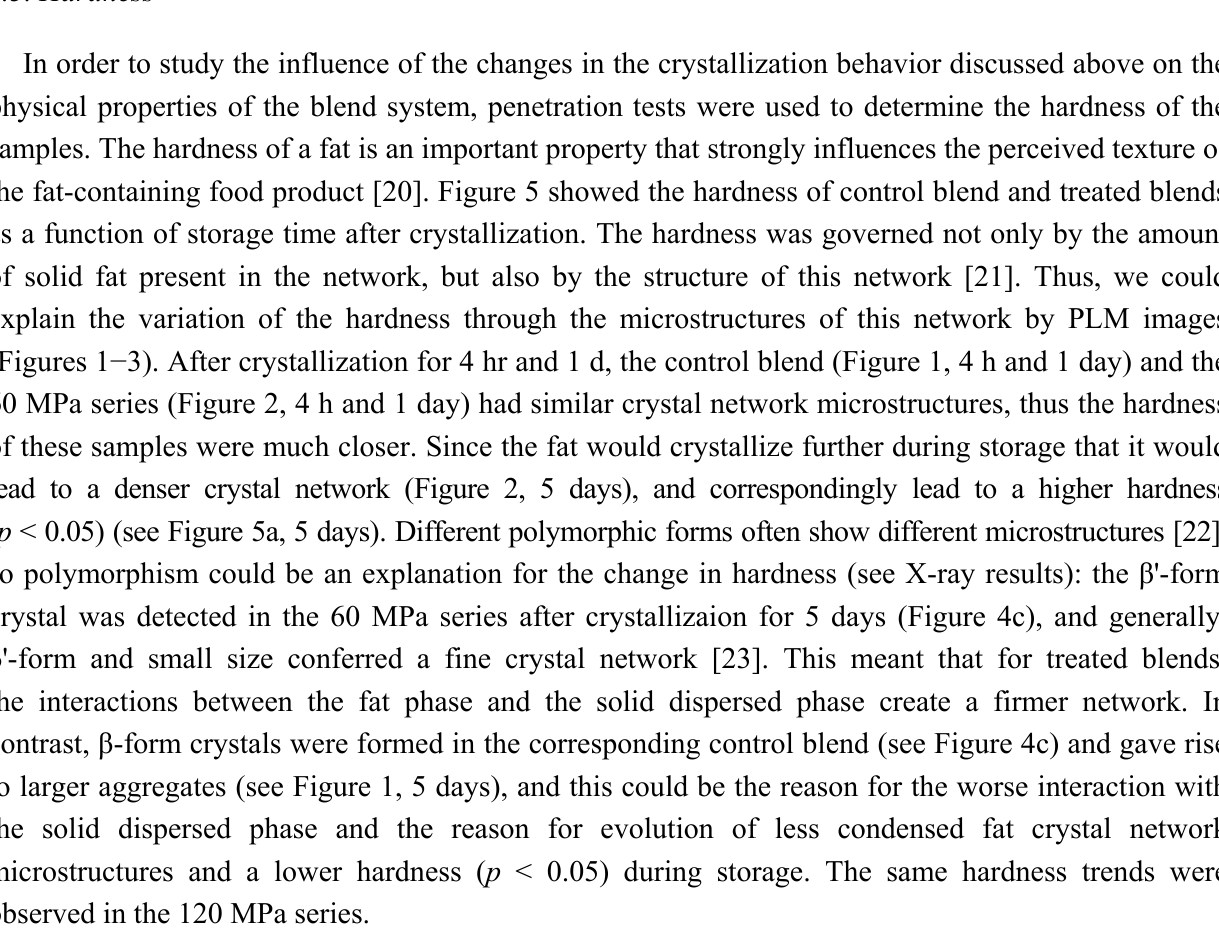
Figure 5. Hardness of control blend and different treated pressures ( a : 60 MPa and b : 120 MPa) vs. treated times (1 and 2) as a function of storage time (0 h, 4 h, 1 day and 5 days) at 0 °C obtained with penetrometry. Values indicated the mean for two